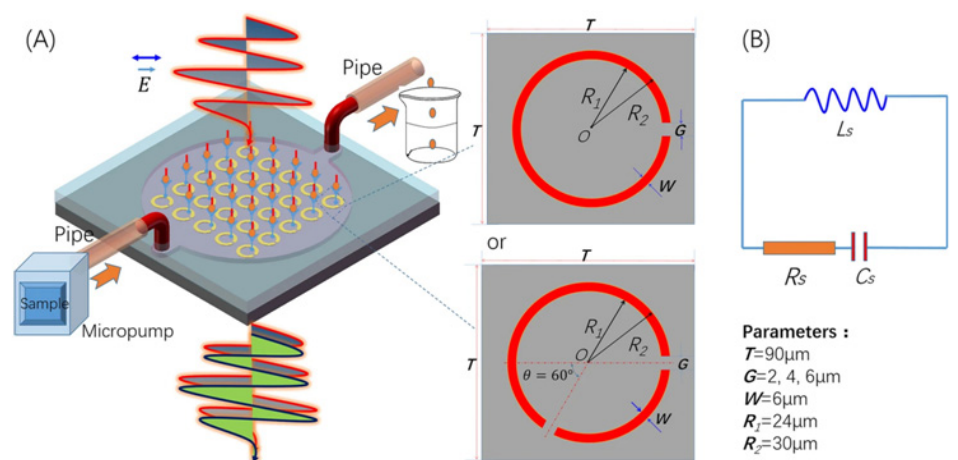
Figure 18. ( A ) Sketch of an SRR-based THz biosensor chip integrated with microfluidics. ( B ) Equivalent circuit and geometric parameters of SRRs. Reprinted from [181].